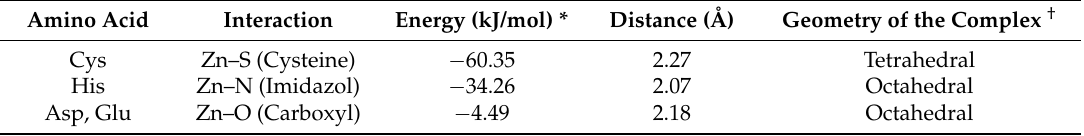
Table 2. Characteristics of zinc interactions with single amino acid side